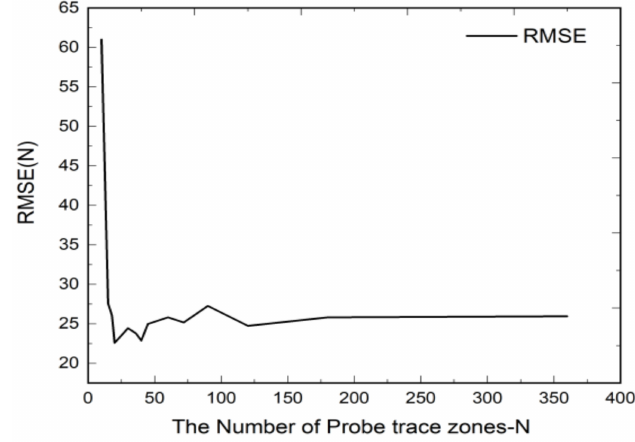
Figure 17. Variation diagram of the RMSE under different partition